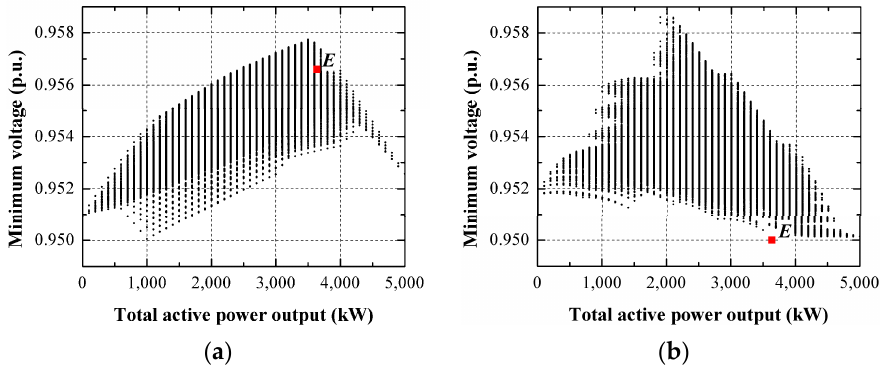
Figure 13. Minimum voltage according to the total active power output of DGs: Case 2 for Five-DG system, ( a ) FV control; ( b ) proposed control.